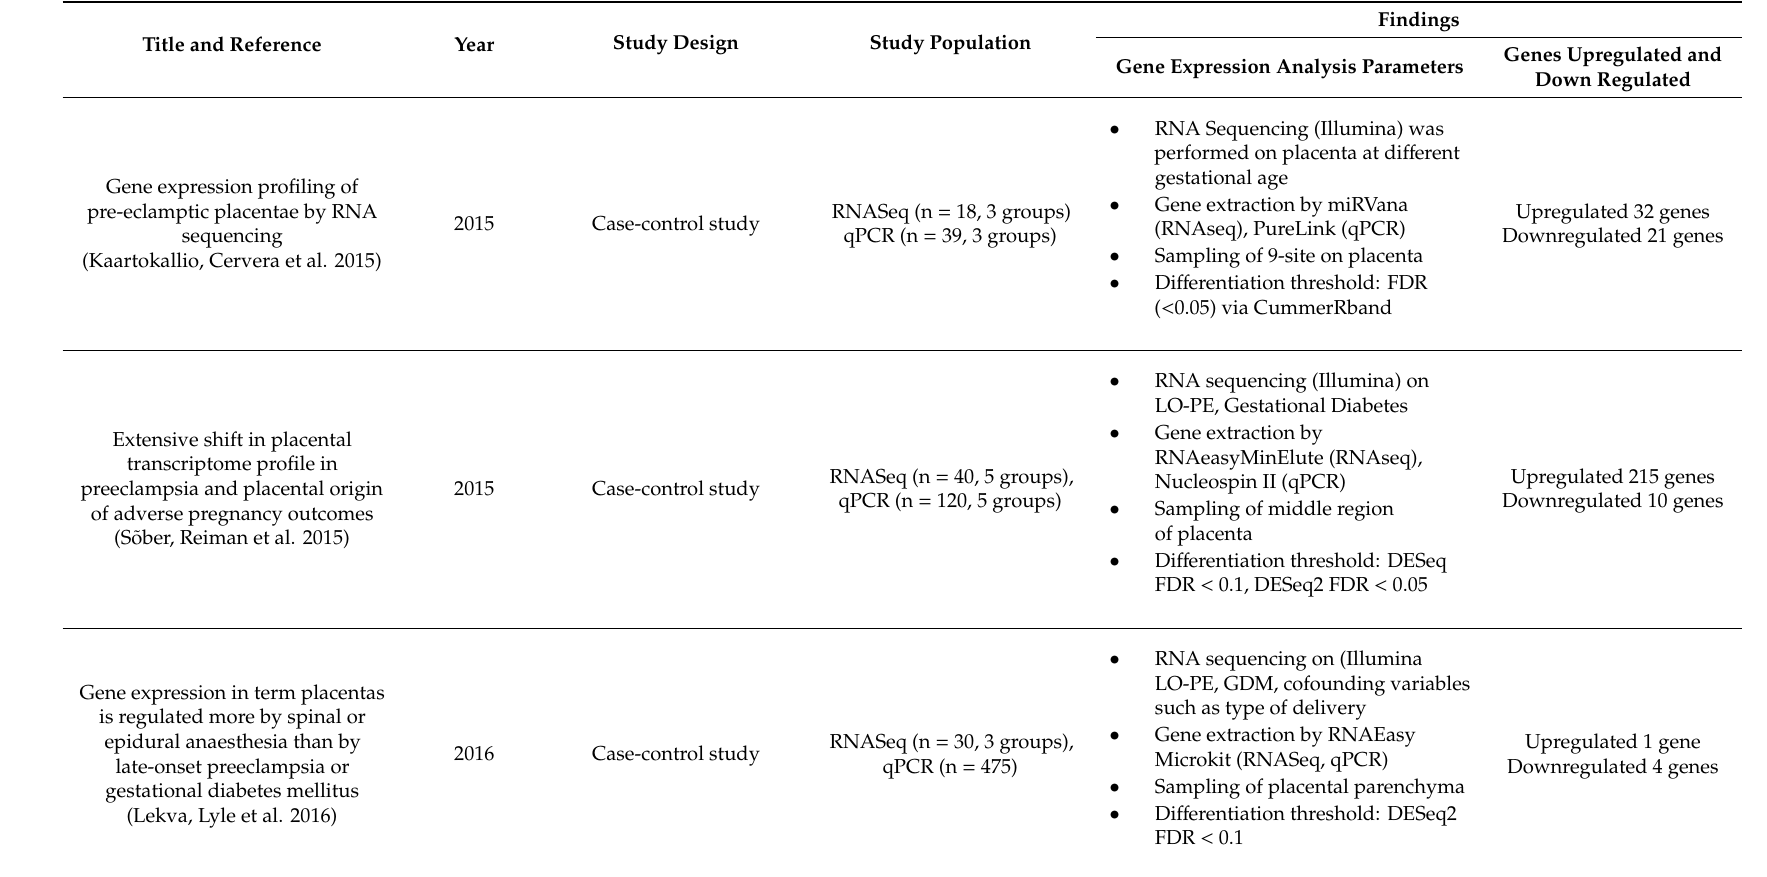
Table 1. Summary of the selected